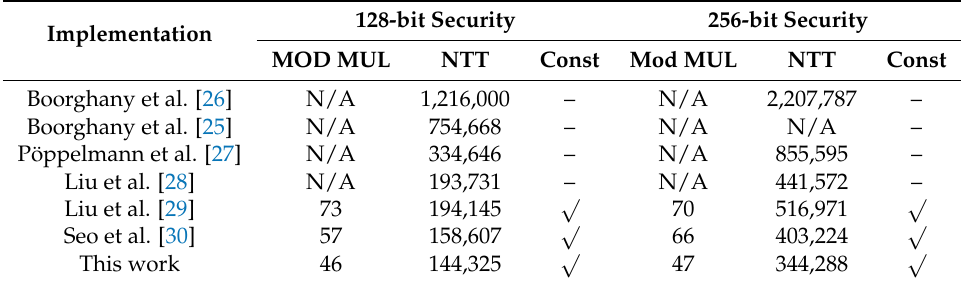
Table 1. Execution time of modular multiplication and Number Theoretic Transform (NTT) (in clock cycles), where 128-bit security represents ( n : 256, q : 7681) and 256-bit security represents ( n : 512, q